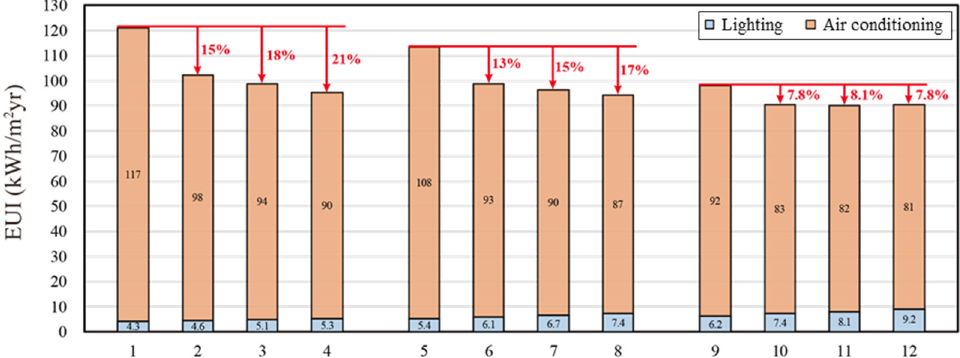
Figure 17. Energy simulation analysis of cases with WWR = 80%.